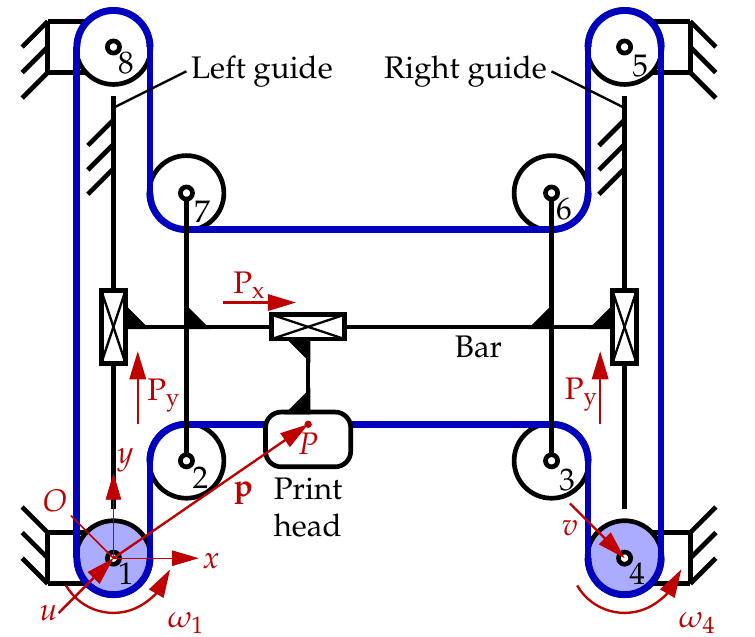
Figure 3. Schematic of an H-bot routing (as seen from the top of the printer). The pulleys connected to the motors (1 and 4) are colored, while the other pulleys are in white; the belt that wraps around the pulleys is in blue. The rectangles denote P joints, while the small circles correspond to R joints.